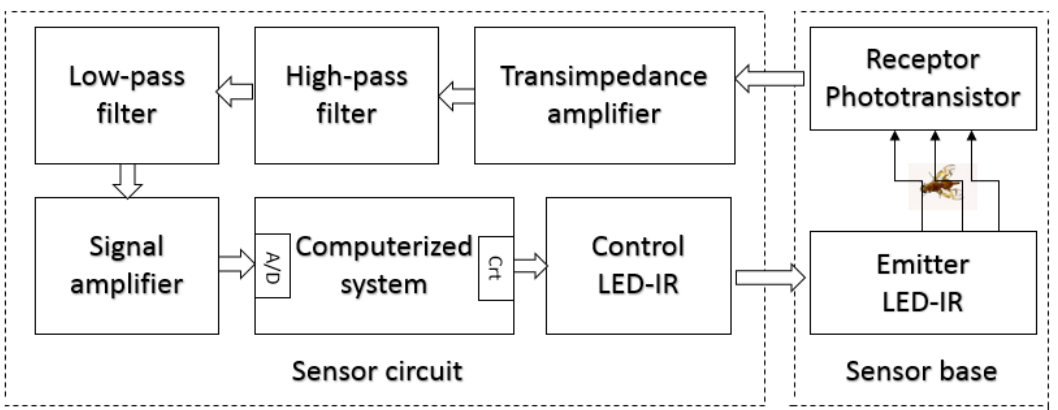
Figure 5. Diagram in sensor circuit